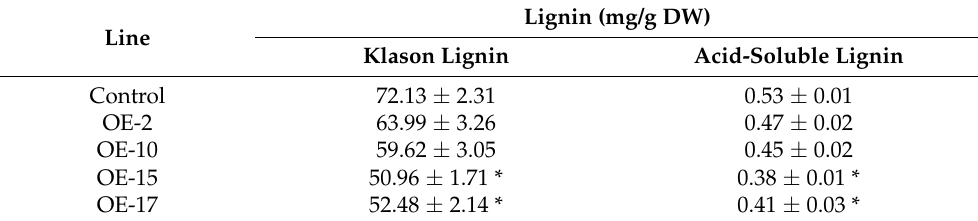
Table 1. Lignin contents in the roots of the SmLAC3 -OE lines and the